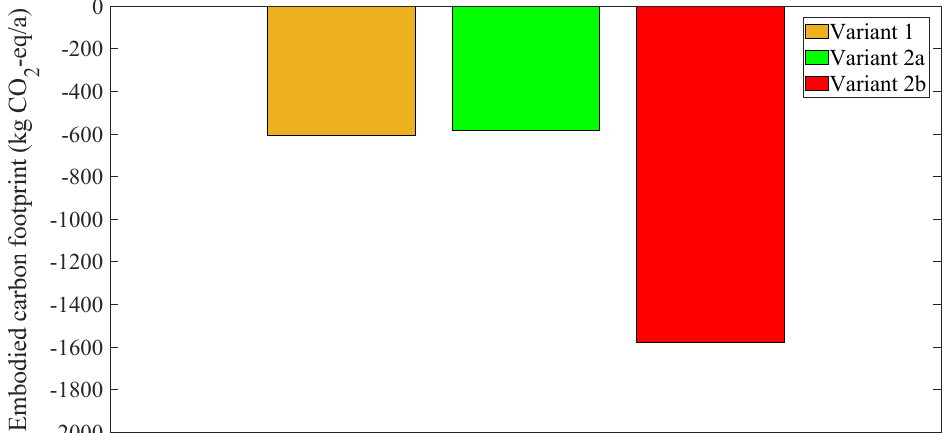
Figure 10. Embodied carbon emissions of the three synergetic retrofitting alternatives .